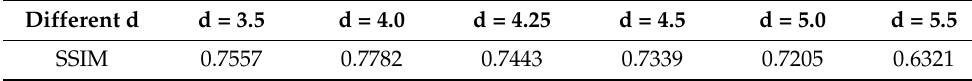
Table 3. The average SSIM for the reconstructed targets in Figure 10. Different d d = 3.5